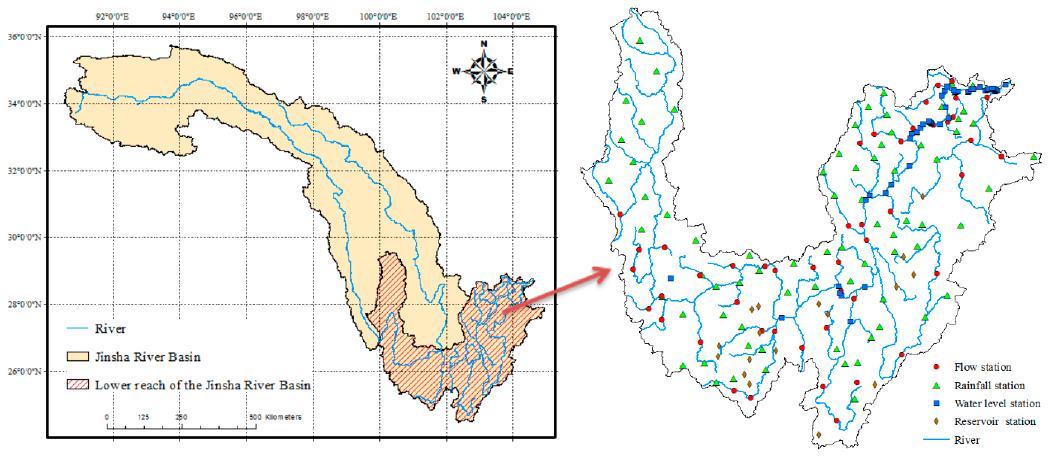
Figure 7. Location of the study area.